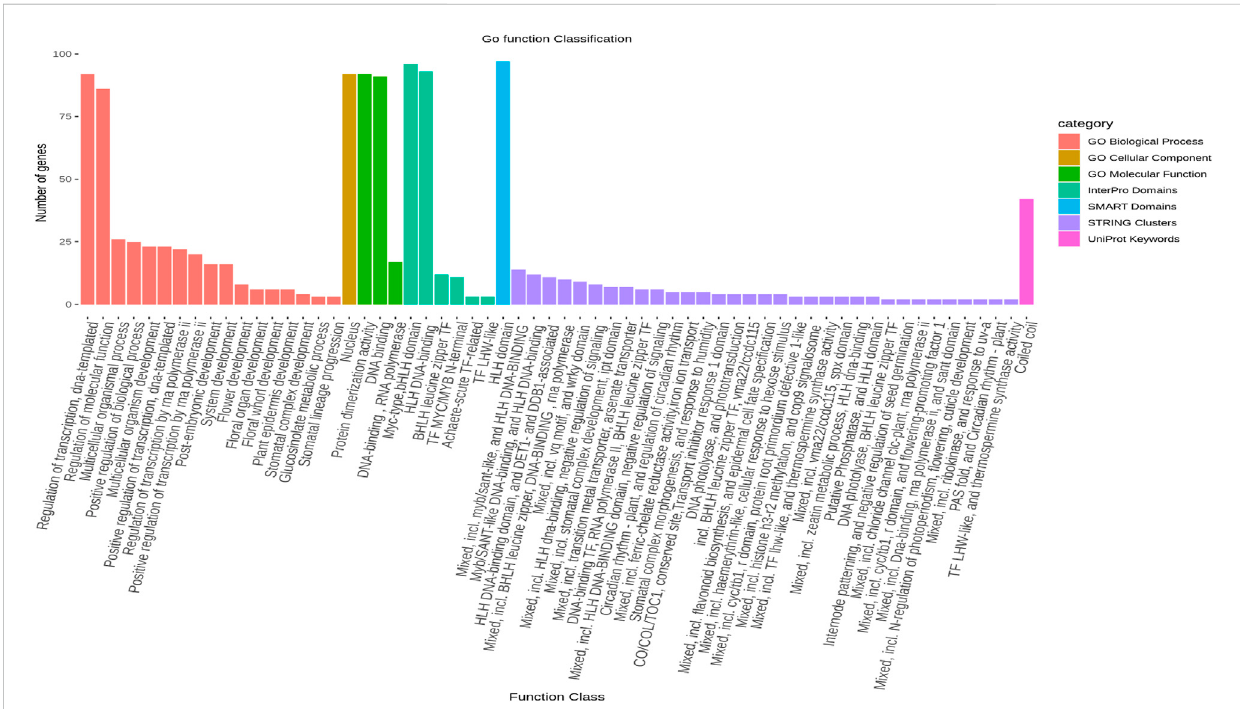
FIGURE 5 The gene ontology (GO) analysis of LsbHLH proteins was conducted in seven distinct categories, including Go Biological Process, Go Cellular Component, Interpro Domains, SMART Domains, STRING Clusters, UniProt, and Go Molecular Functions. The fi gure represents the number of genes involved in each gene ontology term as a bar